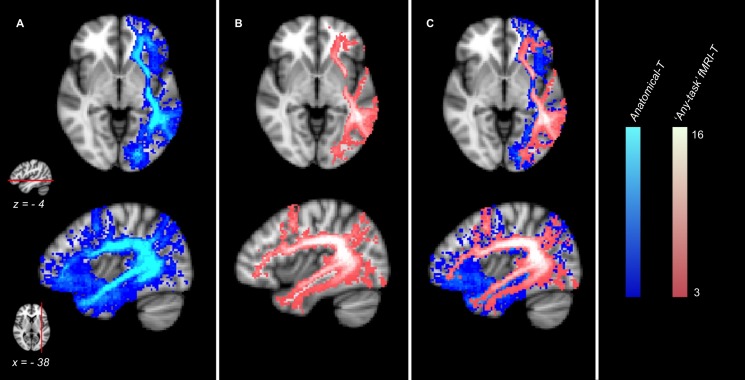
Anatomical and fMRI-targeted Tractography Atlases (group analysis) of 16 healthy controls. (A) Anatomical Tractography; (B) “any-task” fMRI-targeted Tractography (all tasks included); (C) (A) and (B) overlayed. Only voxels represented in at least three subjects are displayed. Color brightness of each voxel is proportional to the number of subjects in whom the voxel was represented. The reference axial and parasagittal MNI slices (MNI z = –4, x = –38, respectively) are shown on the left side of the figure.